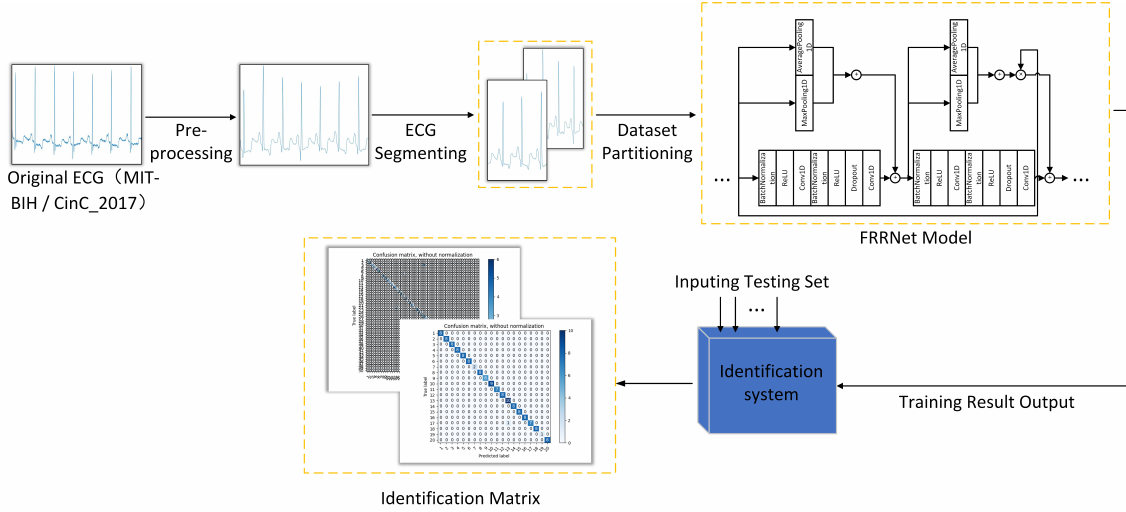
Figure 2. System flow